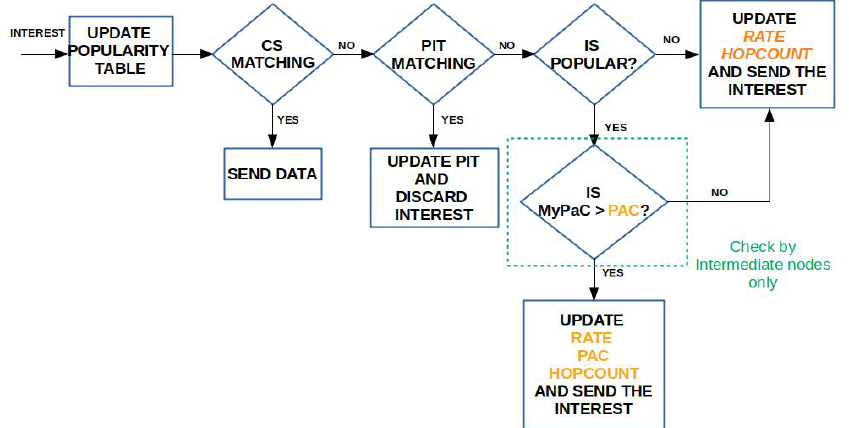
Figure 4. Interest processing in the presence of PaC-based caching.